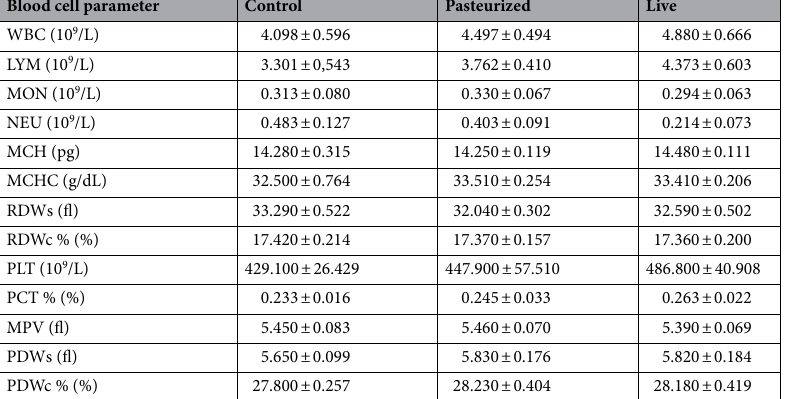
Table 3. Haematological parameters after oral administration of P. copri for 29 days. Values are presented as mean ± SEM (n = 10). No mean values were significantly different from the control group (p < 0.05). WBC white blood cell count, LYM lymphocytes, MON monocytes, NEU neutrophils, MCH mean corpuscular haemoglobin, MCHC mean corpuscular haemoglobin concentration, RDWs red cell distribution width—SD, RDWc red cell distribution width—CV, PLT platelet count, PCT thrombocrit, MPV mean platelet volume, PDWs platelet distribution width—SV, PDWc platelet distribution